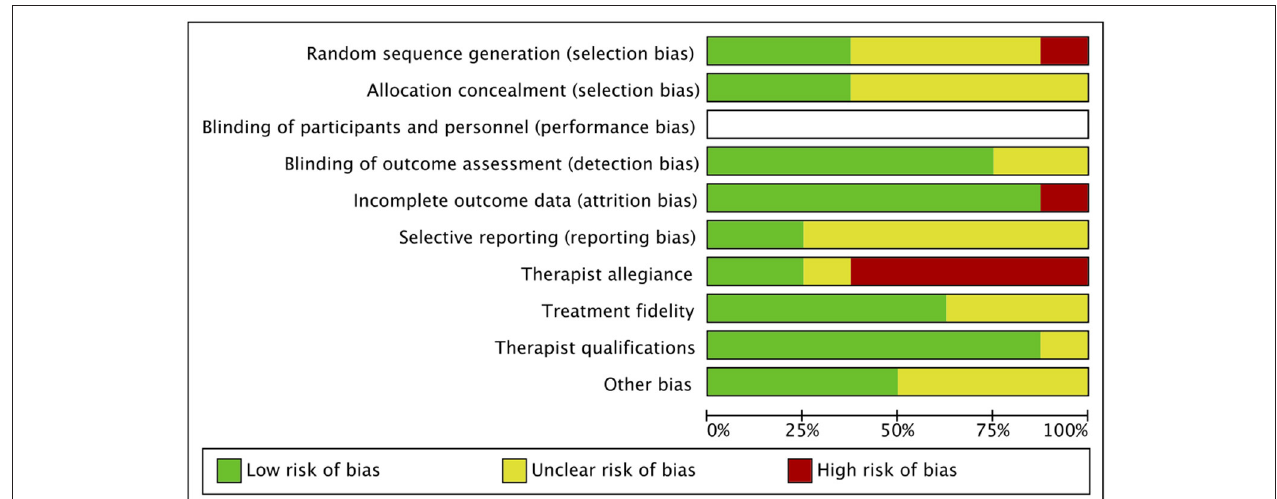
FIGURE 3 | Risk of bias graph.